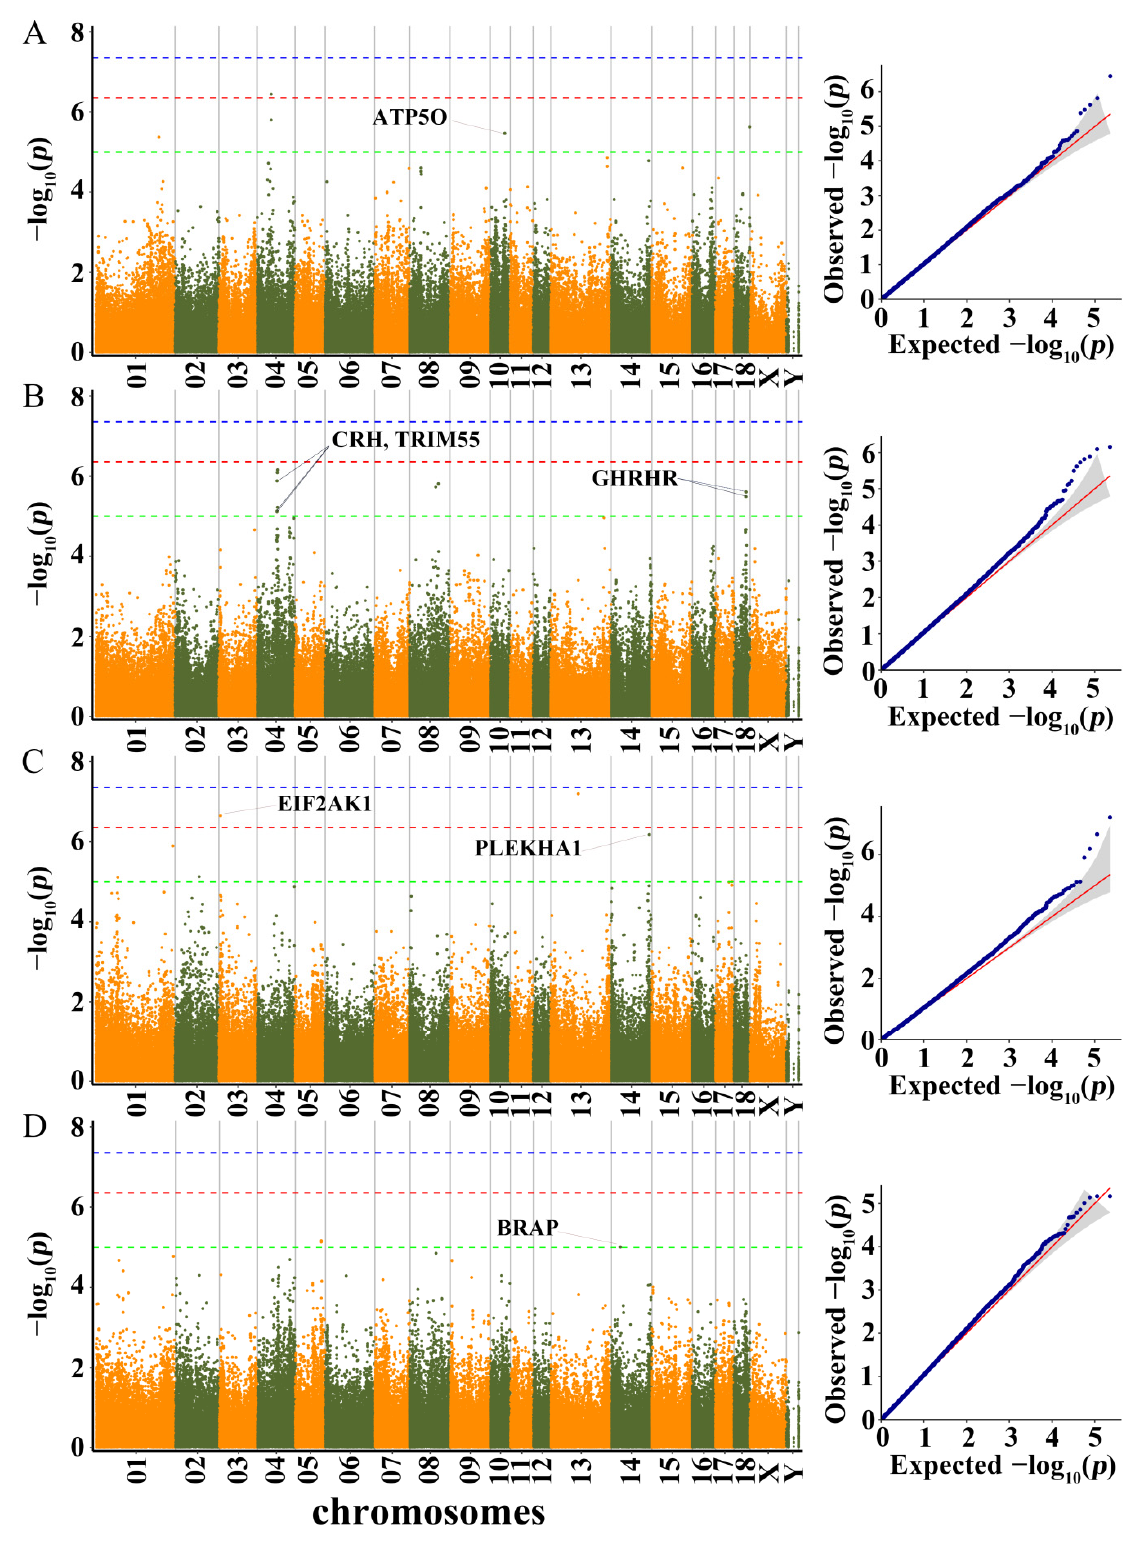
Figure 3. Manhattan plots and QQ plots for LBT, ADG30–60, ADG60–100, and ADG30–100 using MLM. ( A ) LBT, ( B ) ADG30–60, ( C ) ADG60–100, ( D ) ADG30–100. Negative log 10 p -values of the filtered high-quality SNPs were plotted against their genomic positions. The dashed lines of green, orange and blue correspond to the Bonferroni-corrected thresholds of p = 1.00 × 10 − 5 ( − log 10 p = 5), p = 4.39 × 10 − 7 ( − log 10 p = 6.36) and p = 4.39 × 10 − 8 ( − log 10 p = 7.36), respectively.